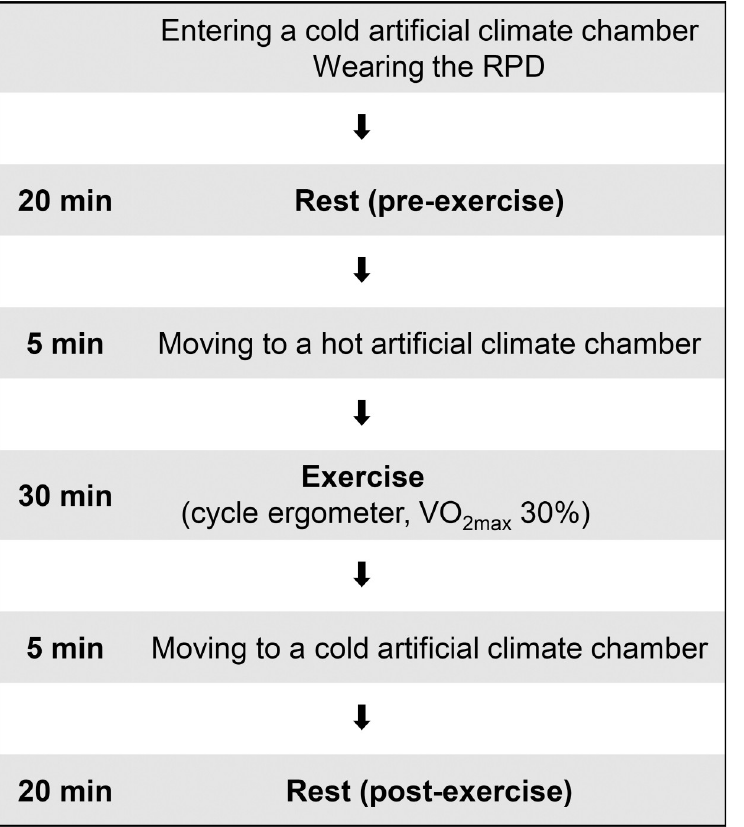
Fig 4. Outline of the experiment for the measurement of temperature. Cold artificial climate chamber: dry-bulb temperature of 28˚C and relative humidity of 45%, RPD: respiratory protective device; hot artificial climate chamber: dry-bulb temperature 36˚C and relative humidity 45%; VO 2max : maximal oxygen